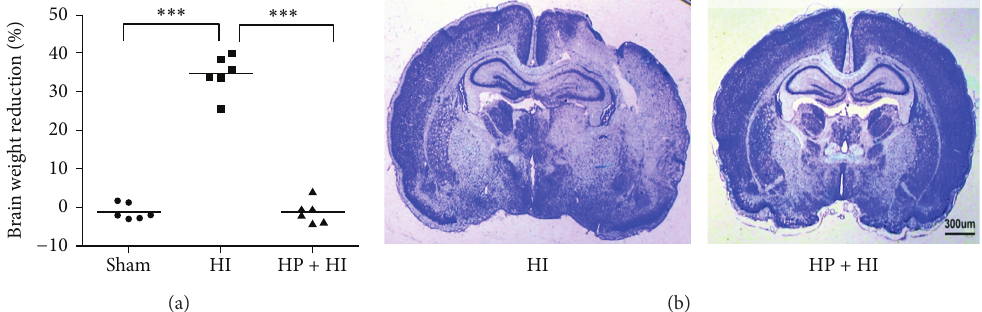
Figure 1: Hypoxia preconditioning exerts significant neuroprotection in neonatal hypoxia-ischemia brain injury. (a) The ratio of hemispheric brain weight reduction measured 7 days after hypoxia-ischemia injury was significantly reduced in the hypoxia preconditioning group (HP + HI), compared with the hypoxia-ischemia only (HI) group. (b) Nissl stained frozen sections showed extensive brain damage in the ipsilateral hemisphere 24 h after hypoxia-ischemia injury (HI, left panel), which was attenuated by hypoxia preconditioning (HP + HI, right